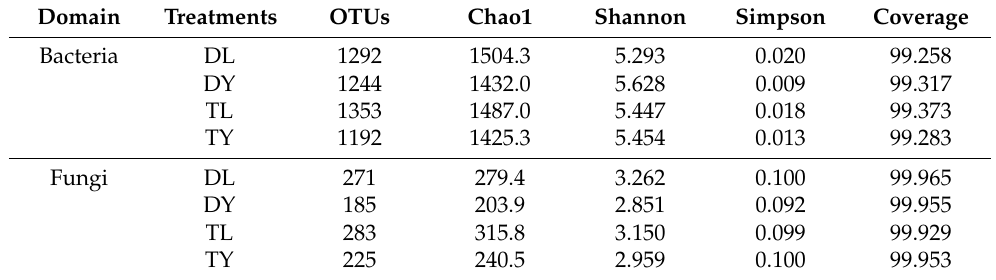
Table 2. MiSeq sequencing coverage and alpha diversity of bacterial 16S rRNA gene and fungal ITS.